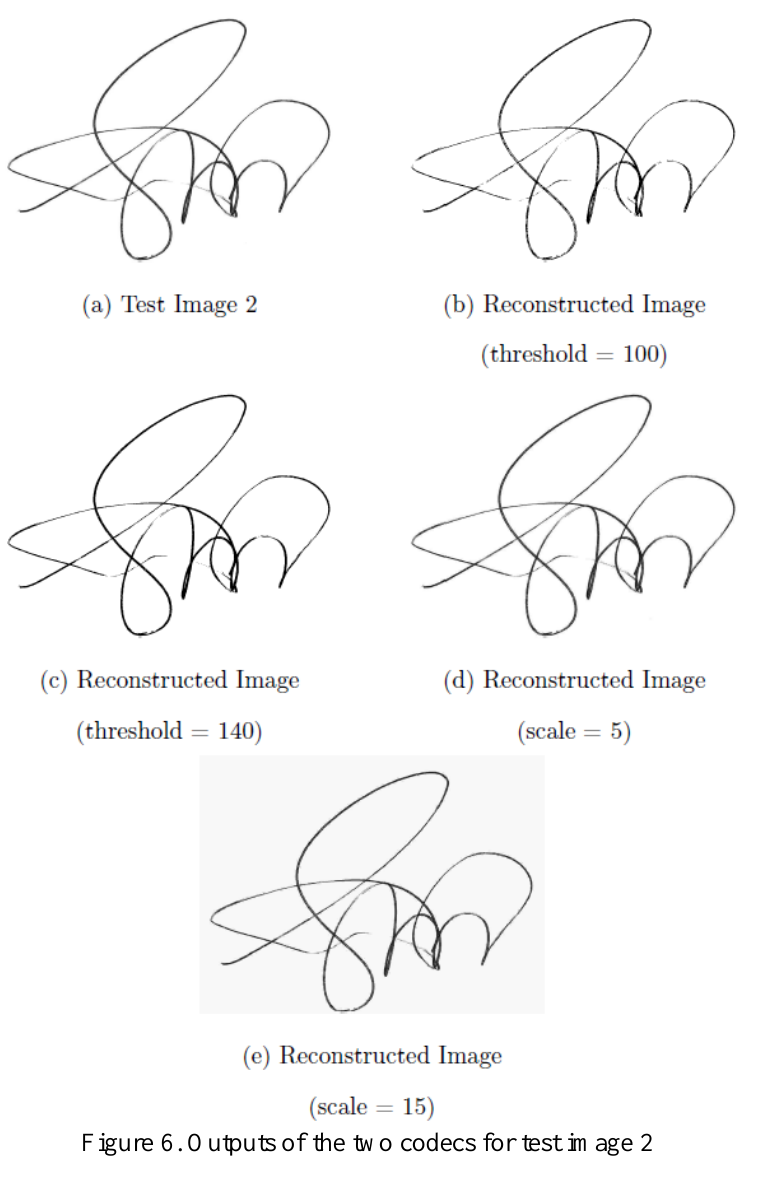
Figure 6. Outputs of the two codecs for test image 2